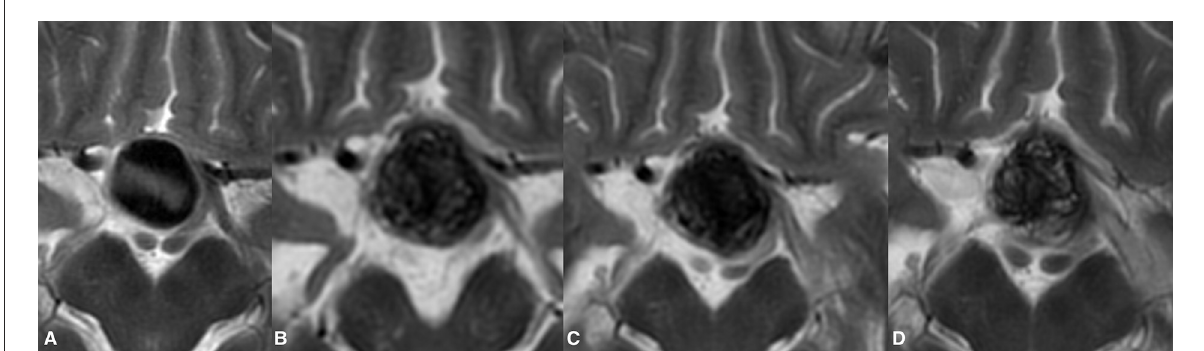
FIGURE2 Post-treatment enlargement of a giant paraophthalmic ICA aneurysm (A) . During routine clinical examinations, the patient showed temporary aggravation of the presenting visual symptoms due to increase chiasmal compression. The first radiological follow-up demonstrated the treatment-related volume increase of the treated aneurysm (B) . Following prolonged steroid and NSID therapy, the patient’s visual status improved notably. Twelve months after the treatment, the observed growth of the aneurysm was seized with documented aneurysmal shrinkage (C) . Lack of signal void within the aneurysm on T2WI in the same patient at 24 months indicates the ongoing aneurysm thrombosis (D) . The last follow-up also noted the collapse of the previous growing aneurysm.